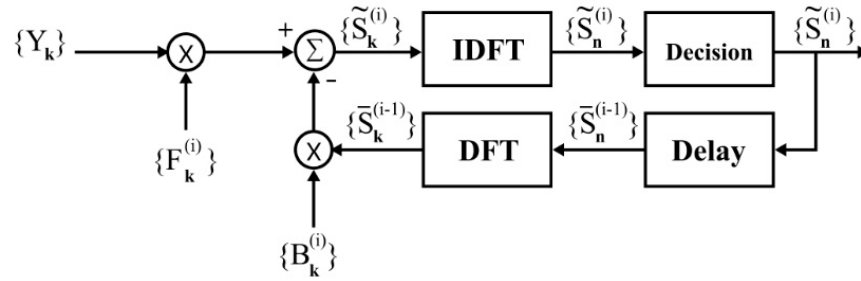
Figure 3. Block diagram of IB-DFE receivers.